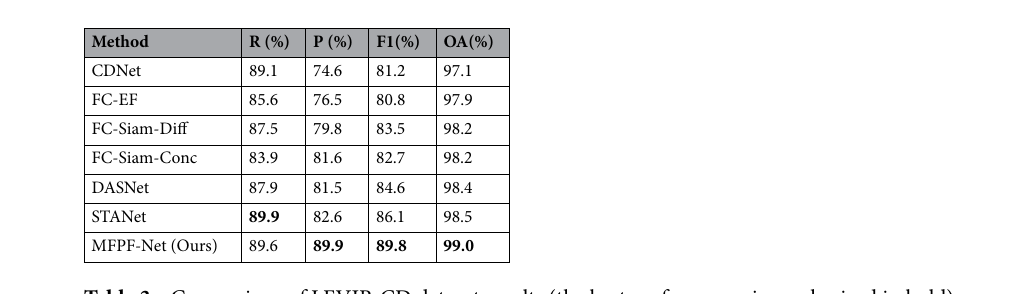
Table 3. Comparison of LEVIR-CD dataset results (the best performance is emphasized in bold).